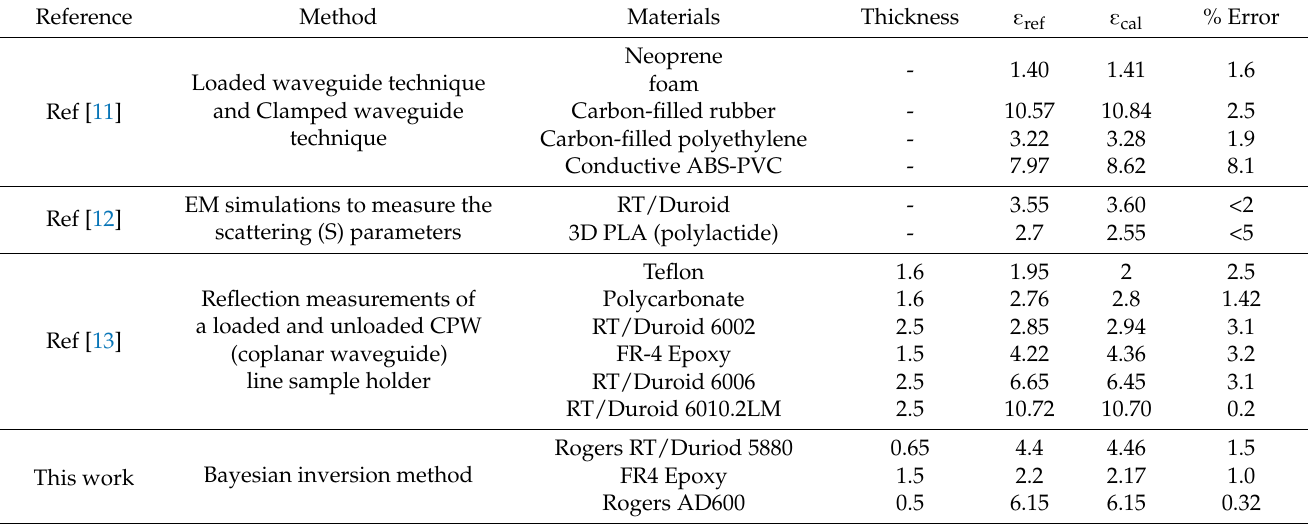
Table 3. Comparison of the Presented Inversion Method with Other